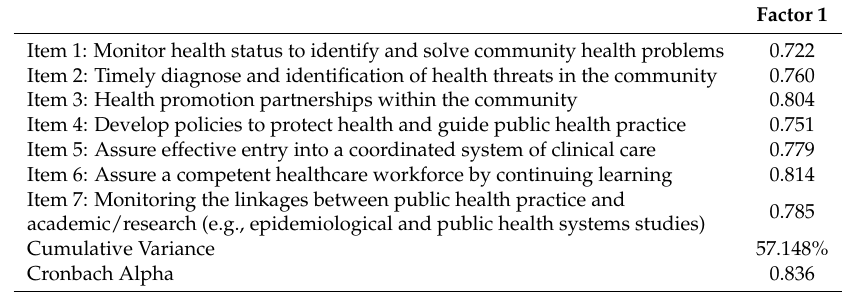
Table 2. Results of factor analysis for public health policies